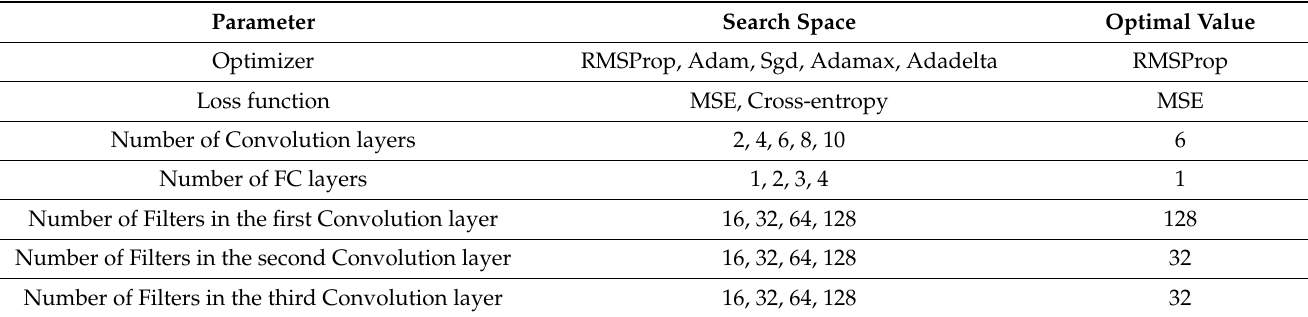
Figure 3. The images related to the two types including ALL and AML. Table 2. Selected parameters in the construction of the proposed